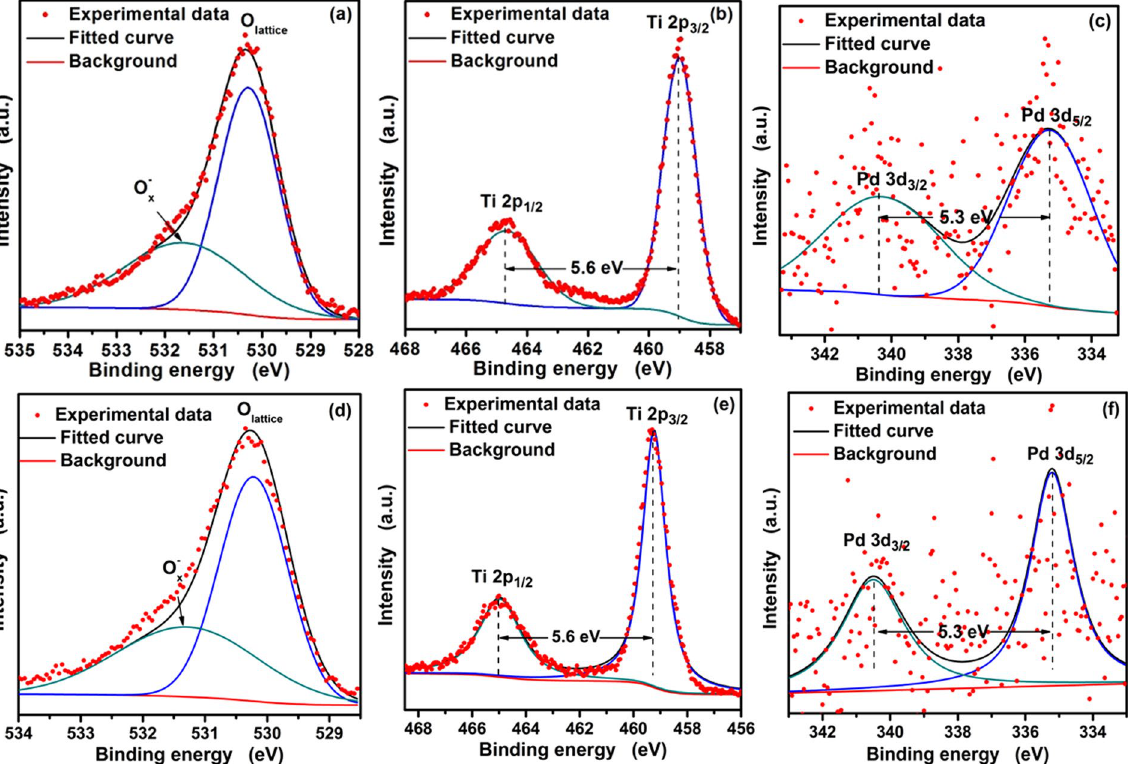
Figure 4. High-resolution XPS spectrum for PTO-4 nanoparticles: ( a ) O 1 s, ( b ) Ti 2p, and ( c ) Pd 3d; High- resolution XPS spectrum for PTO-4 nanoparticles after long-time response: ( d ) O 1 s, ( e ) Ti 2p, and ( f ) Pd 3d.